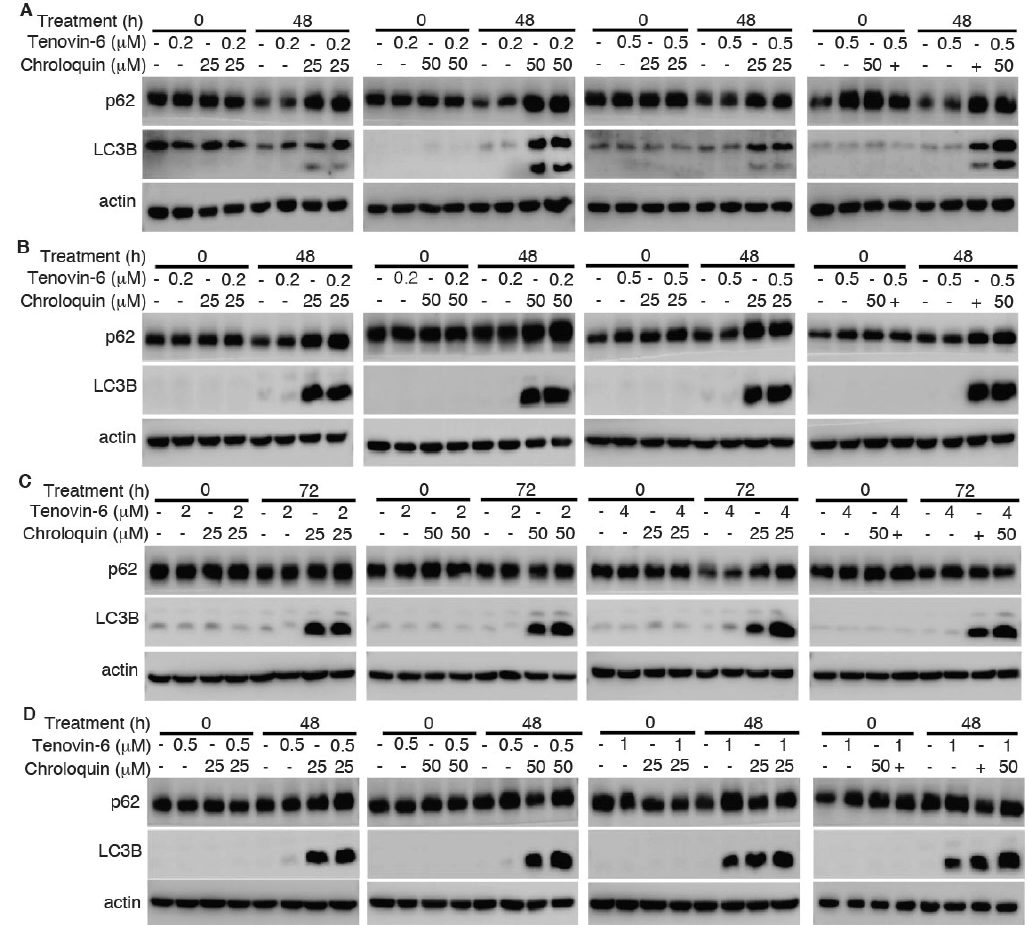
Figure 6. Chloroquine induces microtubule-associated protein 1 light chain 3B (LC3B)-II but blocks autophagy flux to enhance cytotoxicity of Tenovin-6. ( A – D ) Examination of LC3B and sequestosome-1 (SQSTM1)/p62 (p62) protein levels following treatment with Tenovin-6 or chloroquine alone, or in combination for 48 h in AGS ( A ), AGS-EBV ( B ), SNU-719 ( C ), and SNU-1 ( D ) cells.